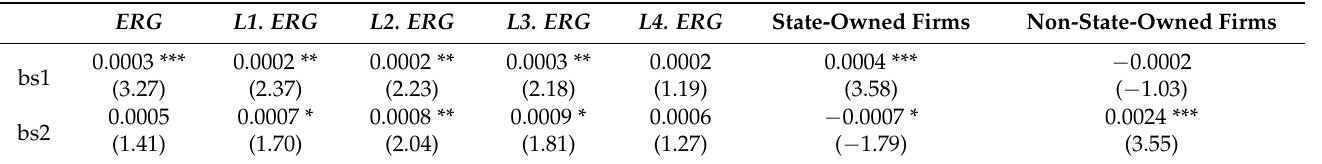
Table 7. The bootstrap test